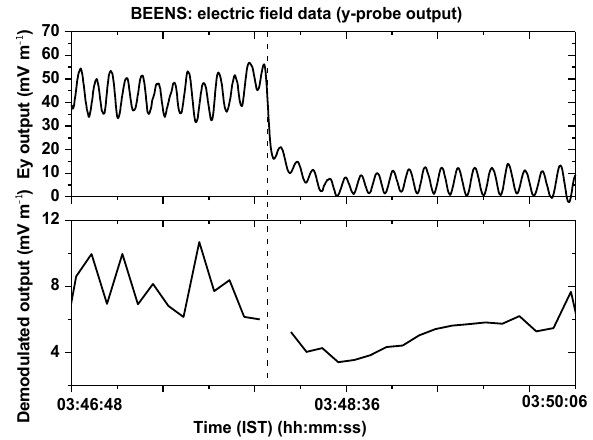
Figure 12. The E y channel output (top panel) (converted to elec- tric field units) for a brief interval of time when the DC torque mo- tor was switched off. In the bottom panel, the demodulated signal is shown. The dashed vertical line represents the time (03:48IST) when the DC torque motor was turned off. For further details, see the text.